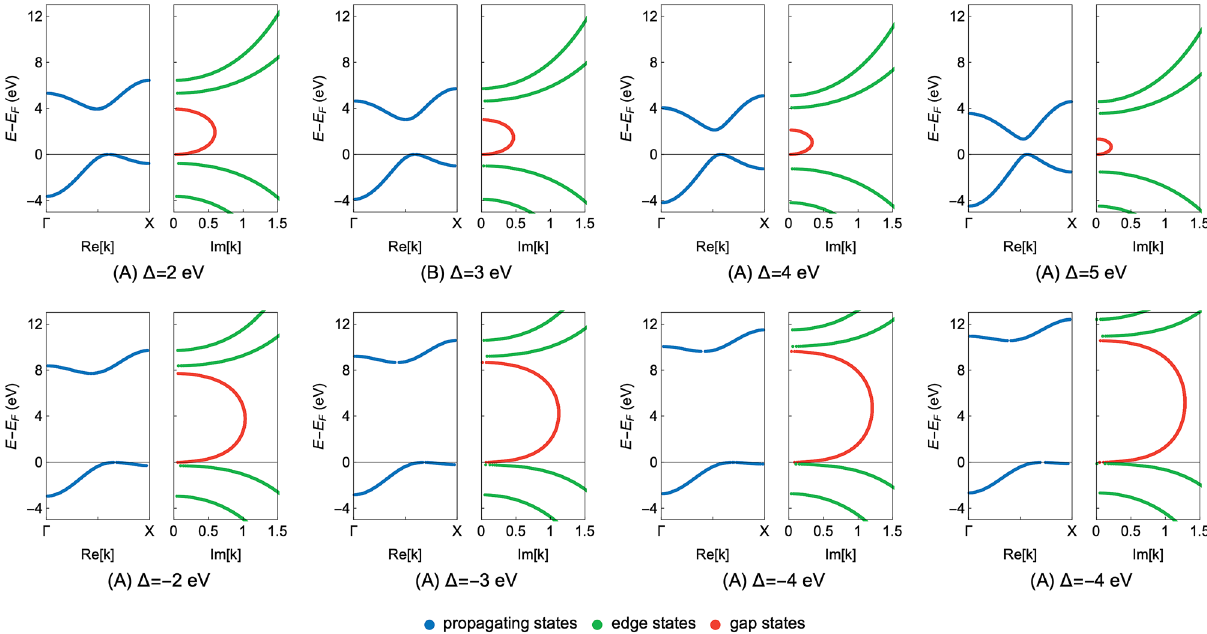
Figure 3. The complex band structures of the CsCl insulator on the Re[ k ] and Im[ k ] axes for the selected values of the onsite energy deviation ( (cid:31) ). The first row of the sub-figures ( A – D ) depicts solutions for the positive values of (cid:31) , whereas the second row ( E – H ) presents results obtained for the negative (cid:31) values. The propagating, edge and gap states are distinguished by the blue, green and red color, respectively. Moreover, the zero energy level is set at the top of the valence band.